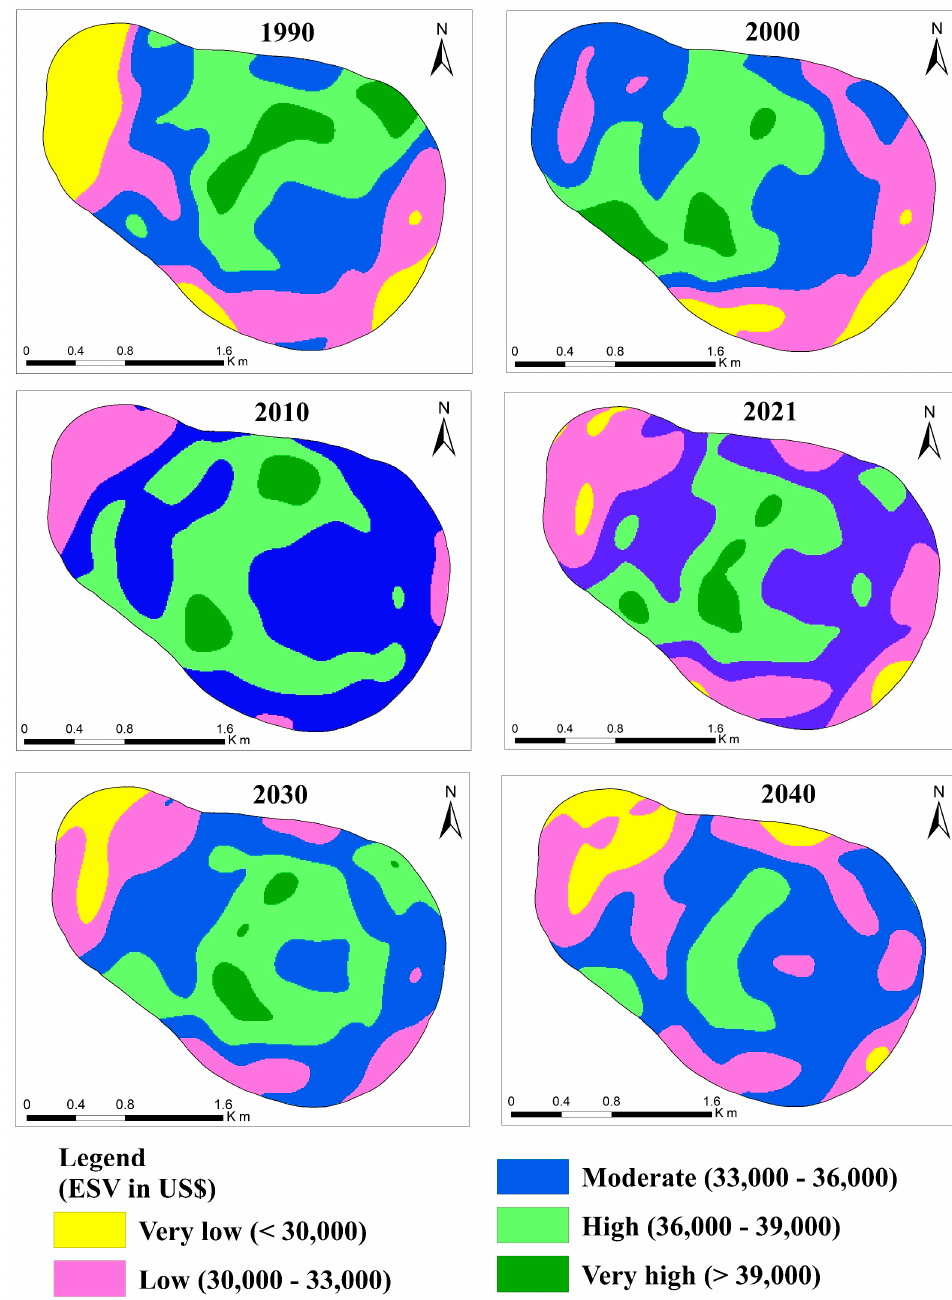
Figure 5. Spatio-temporal di ff erences of the ESV (in USD 10 3 ) based on Costanza et al. (2014). Table 11. Spatio-temporal variation of ESV as per Costanza et al.